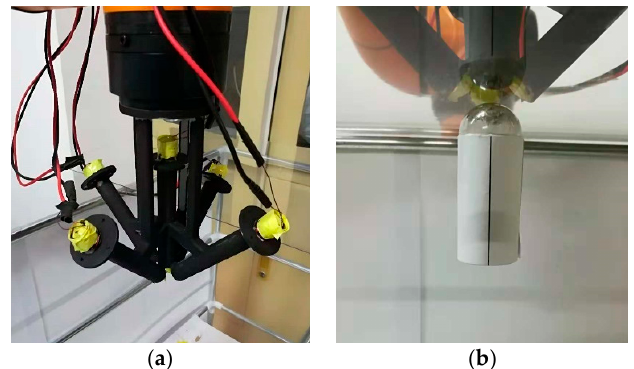
Figure 1. The prototype of laparoscopic robot system: ( a ) is the driving device (the stator) which is consist of five electromagnets, and ( b ) is the laparoscopic robot (the rotor).